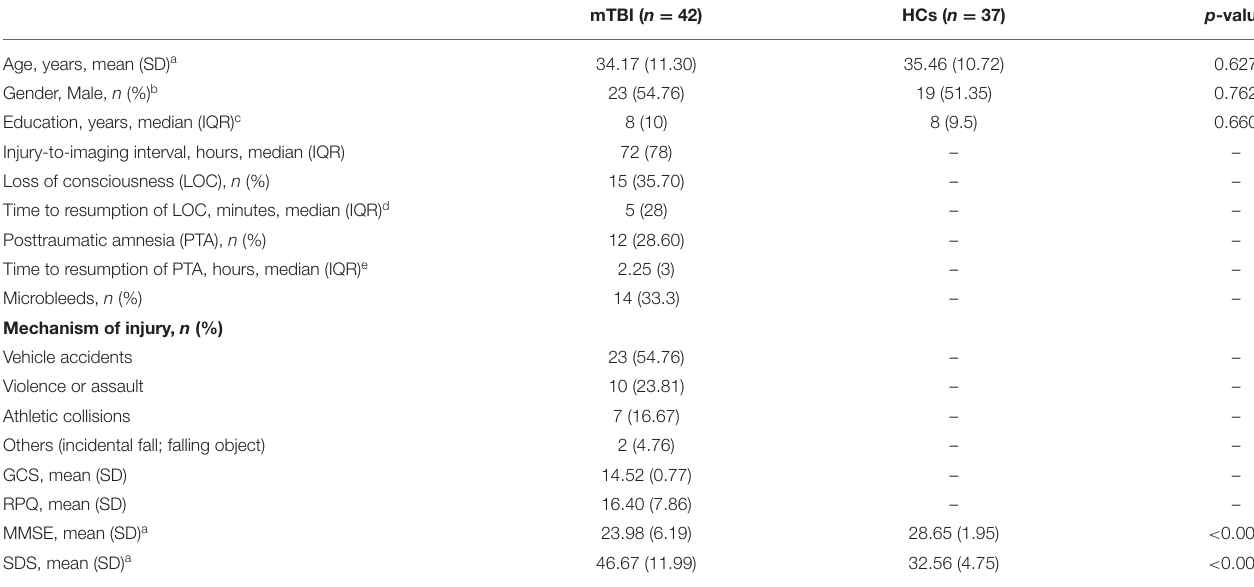
TABLE 1 | Demographic and neuropsychological assessment in patients with mTBI and HCs.